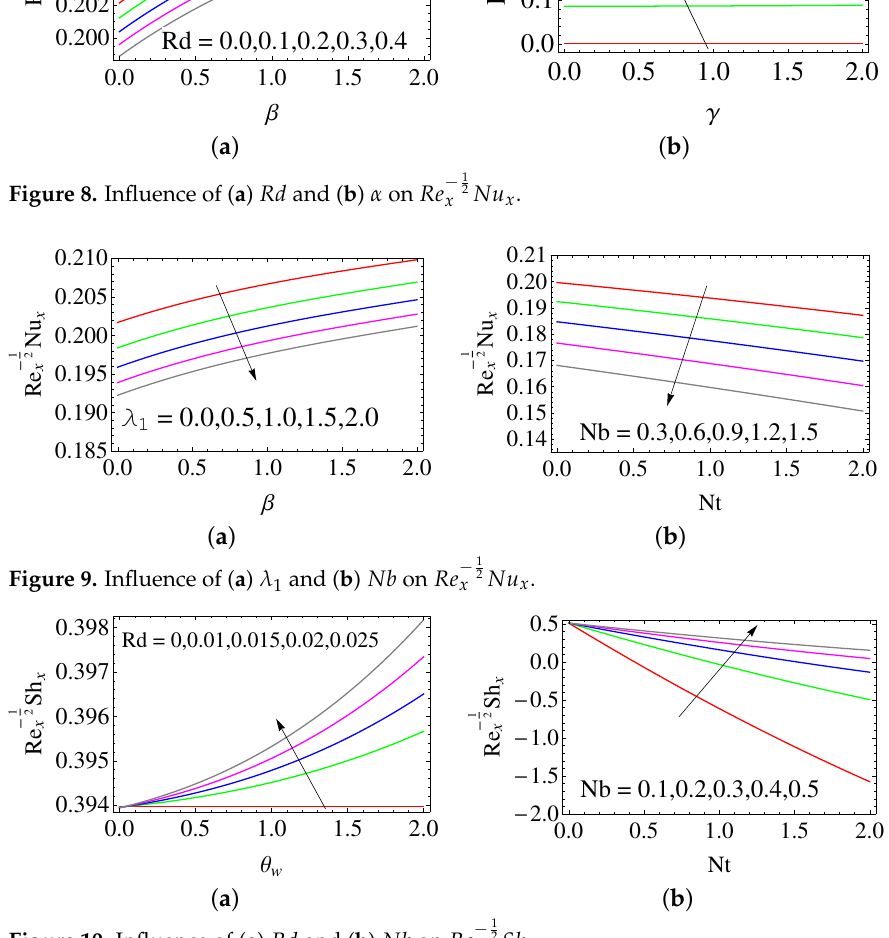
Figure 10. Influence of ( a ) Rd and ( b ) Nb on Re